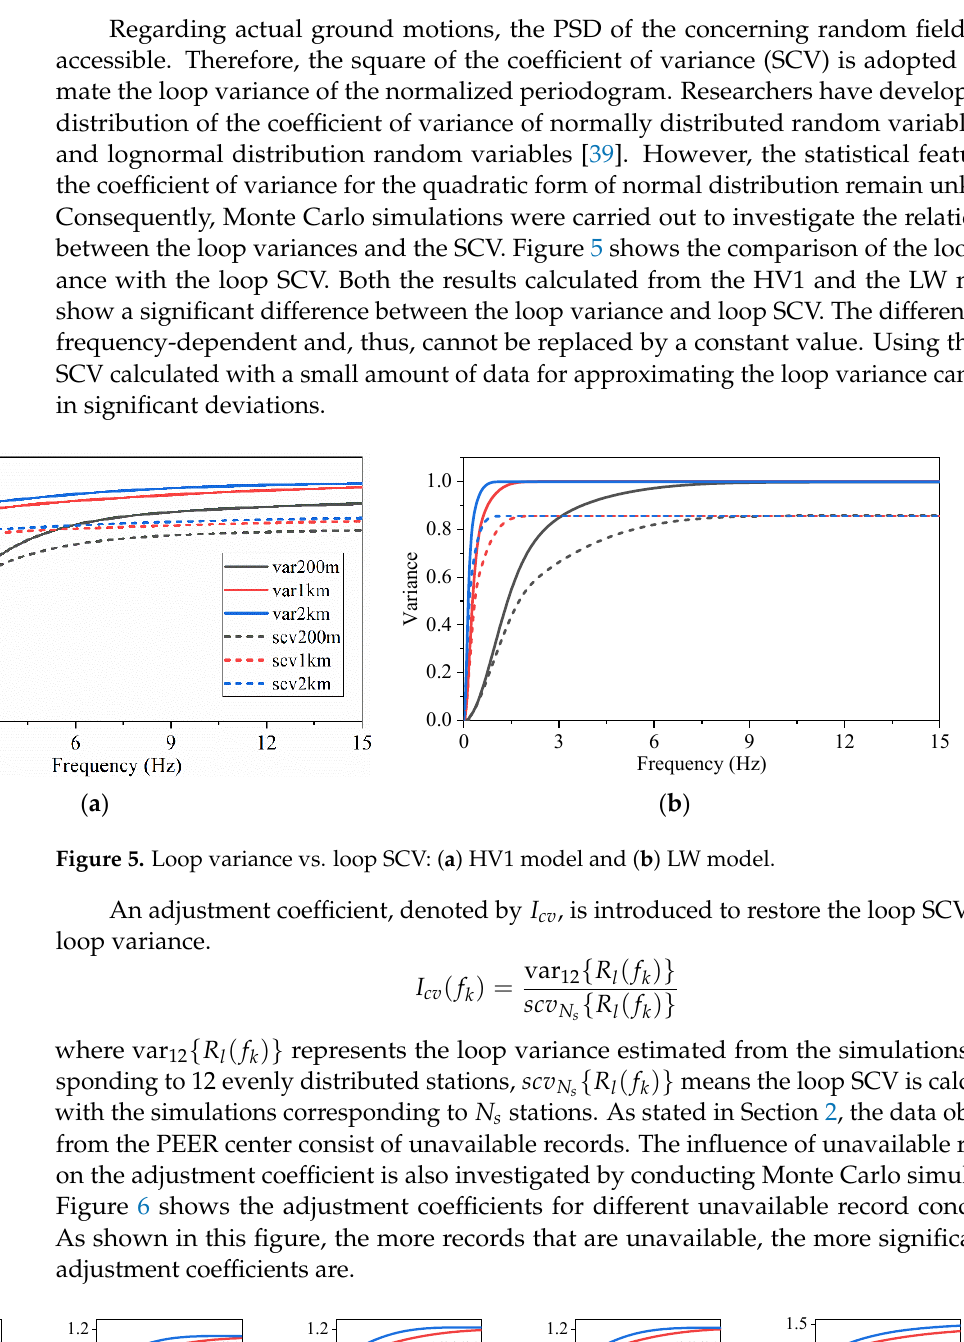
Figure 4. Variances of